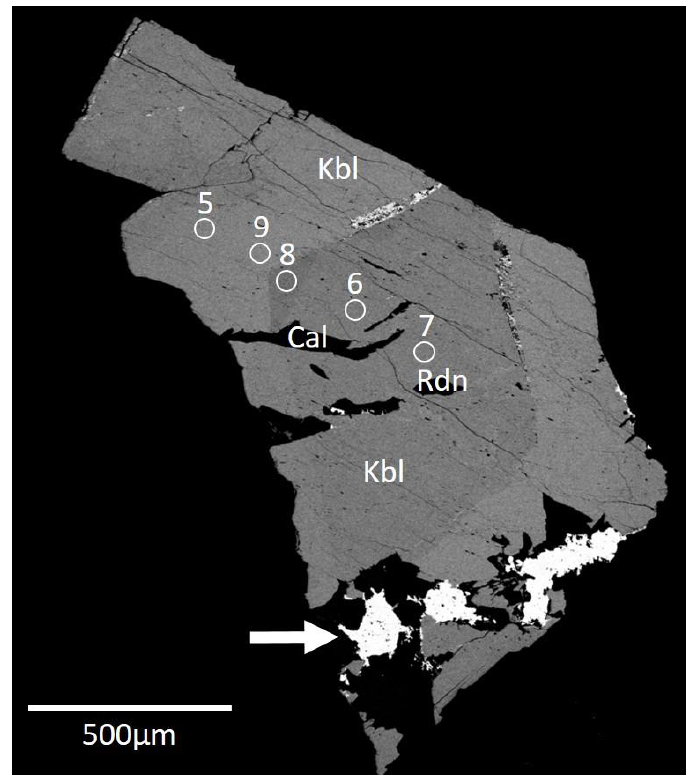
Figure 2. SEM-BSE image (maximum contrast) of a polished section of a kesebolite-(Ce) crystal (Kbl). Patches of rhodonite (Rdn) and manganoan calcite (Cal) occur as inclusions in kesebolite-(Ce); the white arrow points to an intergrowth between gasparite-(Ce) and a possible Mn-analogue to cerite-(Ce). Numbered rings refer to areas of selected point analyses (Table 2 and 3).